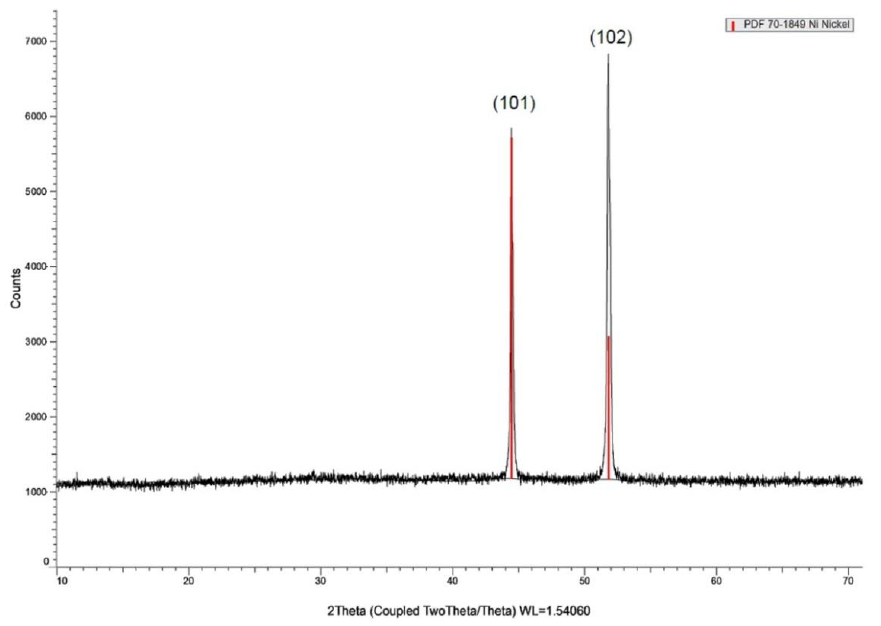
Figure 3. X-ray diffraction (XRD) pattern of Ni/ β -Ni(OH) 2 . Figure 3. X - ray diffraction (XRD) pattern of Ni/β - Ni(OH) 2 . Atomic force microscopy (AFM) was also conducted to evaluate the surface rough- ness upon exposure to a potassium hydroxide solution and coverage with the graphene oxide layer. The texture features of the surface reflect the graduation in its roughness. Thus, the polished Ni electrode in Figure 4a,b showed the least roughness compared to the same after exposure to 0.5 M KOH with polarization forming Ni/β - Ni(OH) 2 in Figure 4c,d. The formation of film layers over the surface of Ni indicates the formation of an oxide film with an increase in the relative surface roughness. The AFM micrograph of a graphene oxide - covered nickel oxide surface showed an elevation in the surface texture that indicates the full coverage of the surface of the substrate in Figure 4e,f. Upon expo- sure to 0.5 M KOH, the graphene oxide layer showed an increase in the elevation of the surface roughness in Figure 4g,h (Ni/β - Ni(OH) 2 /4L GO). These AFM figures confirm the behavior of materials as shown previously by SEM. Table 1 illustrates the surface roughness estimated from AFM. The polished Ni surface has an average surface rough- ness (Ra) of 2.39 ± 0.05 nm, while the Ra of β - Ni(OH) 2 is 7.72 ± 0.08 nm. Furthermore, the roughness in the case of Ni/β - Ni(OH) 2 /4L GO before exposure to 0.5 M KOH equaled 22 ± 0.23 which increased to (Ra = 74 ± 0.31 nm) after exposure to 0.5 M KOH.